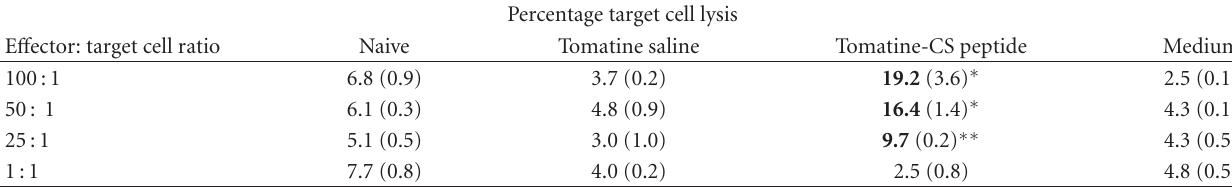
Table 1: Cytolytic activity of splenocytes from mice immunized with adjuvant-antigen preparations of tomatine- P . berghei CS peptide or tomatine-saline following ex vivo restimulation with P . berghei CS peptide (25 μ g/mL). Control cytolytic activity of similarly stimulated splenocytes from naive mice is also shown. Data represent percentage specific lysis of P815 target cells loaded with P . berghei CS peptide or with no peptide (medium control) over a range of e ff ector: target cell ratios. Data shown represent the mean of four mice, assayed individually in triplicate, from one of four similar experiments. Cytolytic activity following CS peptide stimulation (shown in bold): ∗ P < . 025 versus tomatine-saline group, P < . 05 versus naive group, ∗∗ P < . 05 versus tomatine-saline group, determined by the Mann-Whitney U -test. The positive control cytolytic T cell clone CS.C7 specific for P . berghei CS peptide elicited 81.2 and 53.0% P815 cell lysis at an e ff ector: target ratio of 100: 1 and 50 :1, respectively.